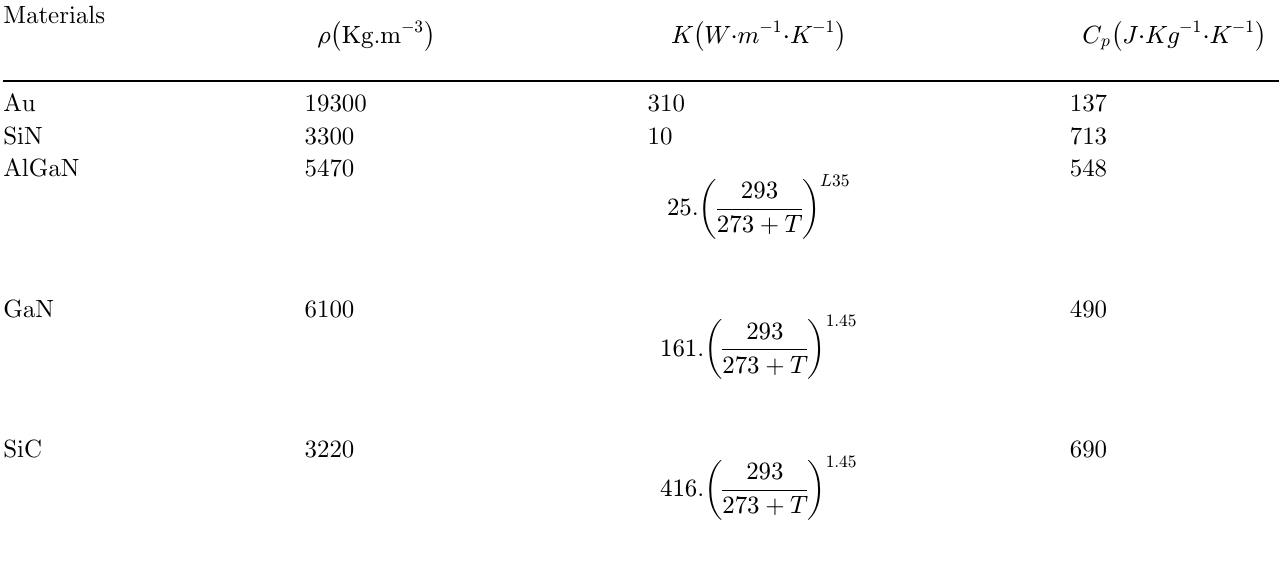
Table 1. Materials thermal properties. Materials